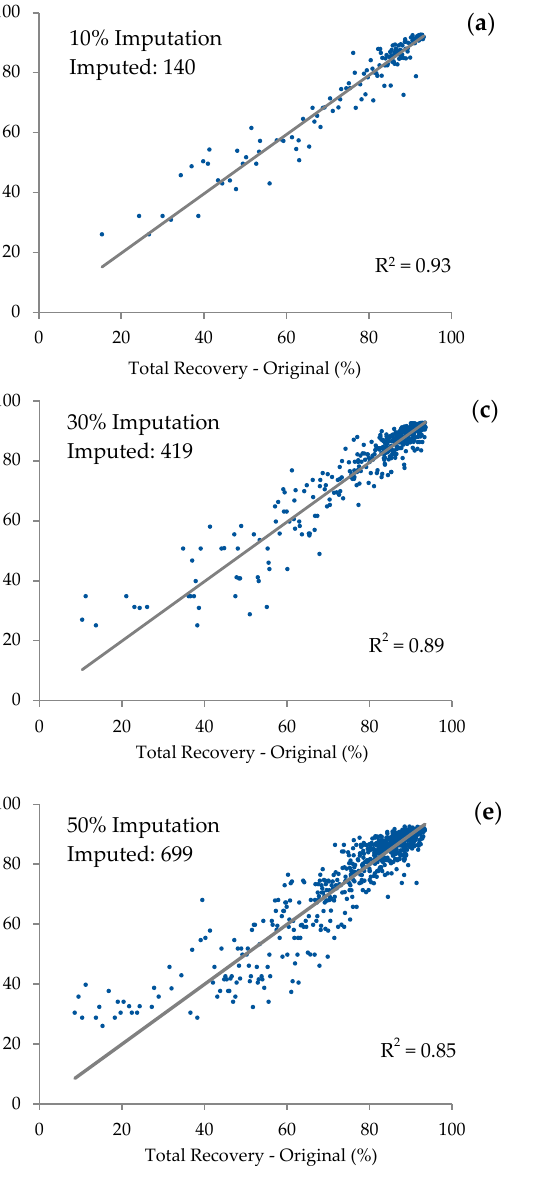
Figure 14. Correlation between the original and imputed total gold recovery data from ( a ) 10%, ( b ) 20%, ( c ) 30%, ( d ) 40%, and ( e ) 50% of sample exclusion. R 2 is the coefficient of determination.